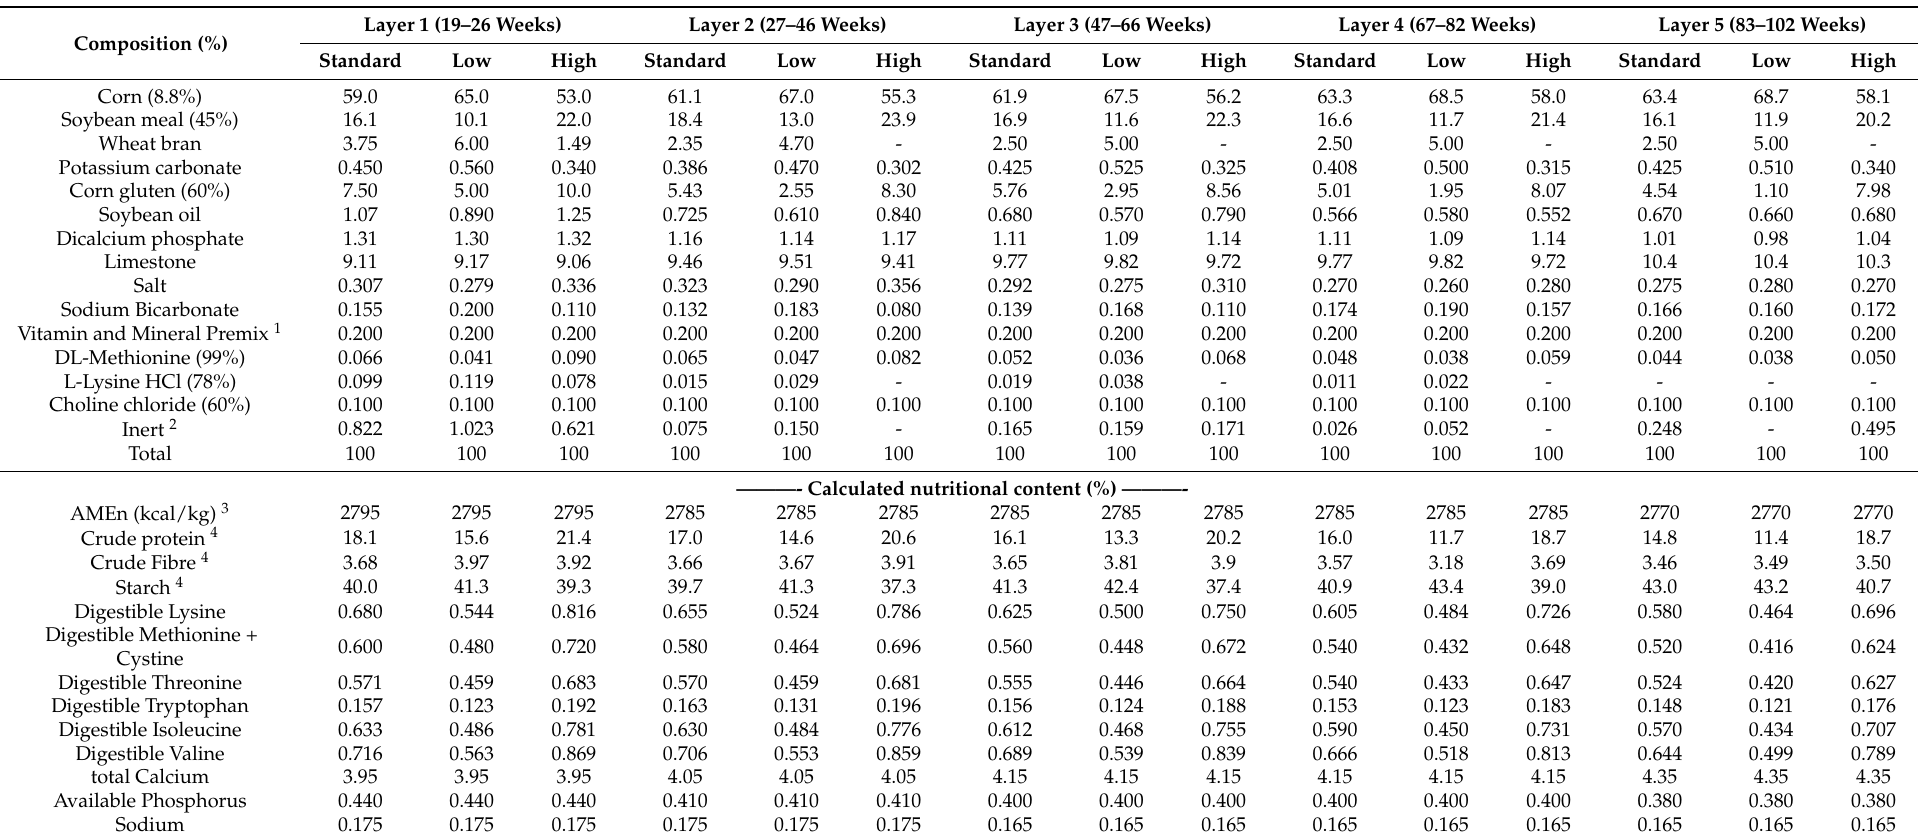
Table 2. Composition and nutritional content of experimental feeds in the laying